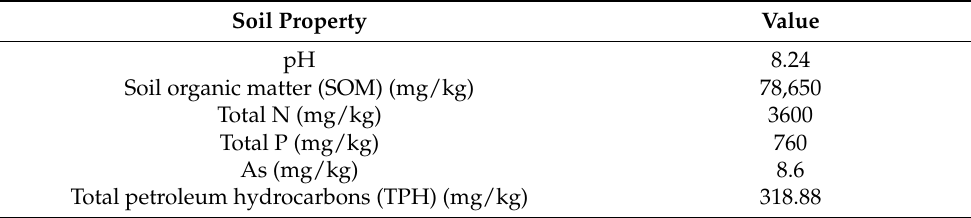
Table 1. Basic soil physicochemical